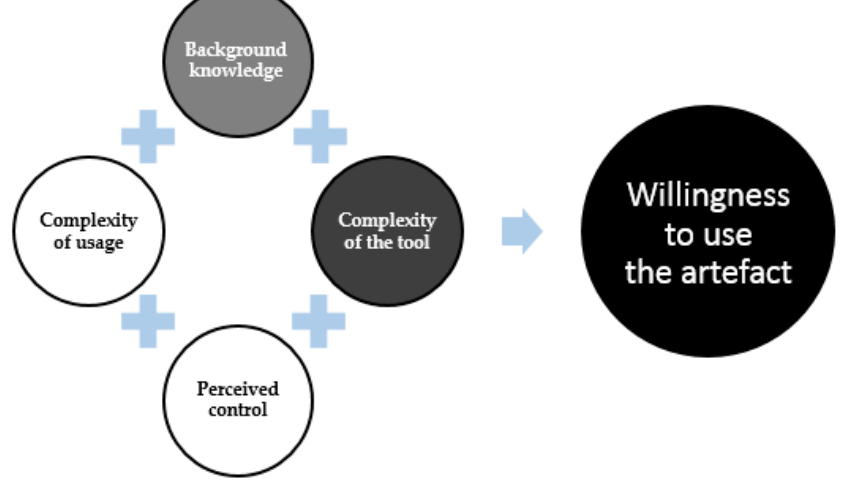
Figure 5. High student willingness to use the artefact as influenced by the similar level of background knowledge and perceived control.